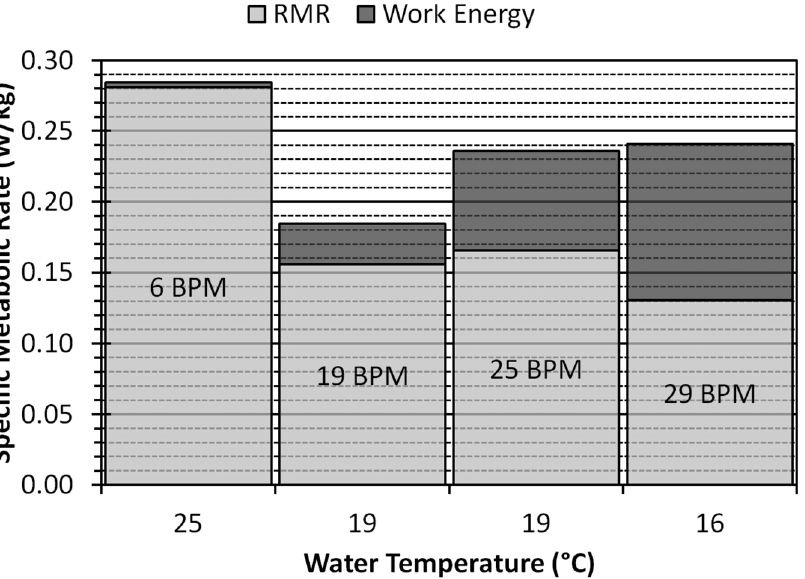
Figure 9. The proportion of specific metabolic rate owing to resting metabolic rate (RMR) and the metabolic cost of flipper movement (Work Energy). Each bar corresponds to a specific ambient water temperature (x-axis) and a specific flipper stroke frequency in beats per minute (BPM) (on bar labels).